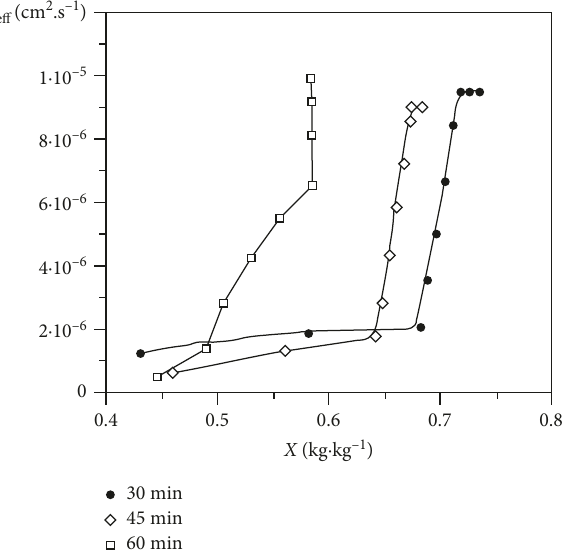
Figure 1: Determination of the effective diffusion coefficient for food gel based on the comparison of the MRI data with the dif- fusion model: effective diffusion coefficient as function of drying time and moisture content (Schrader and Litchfield [28]).